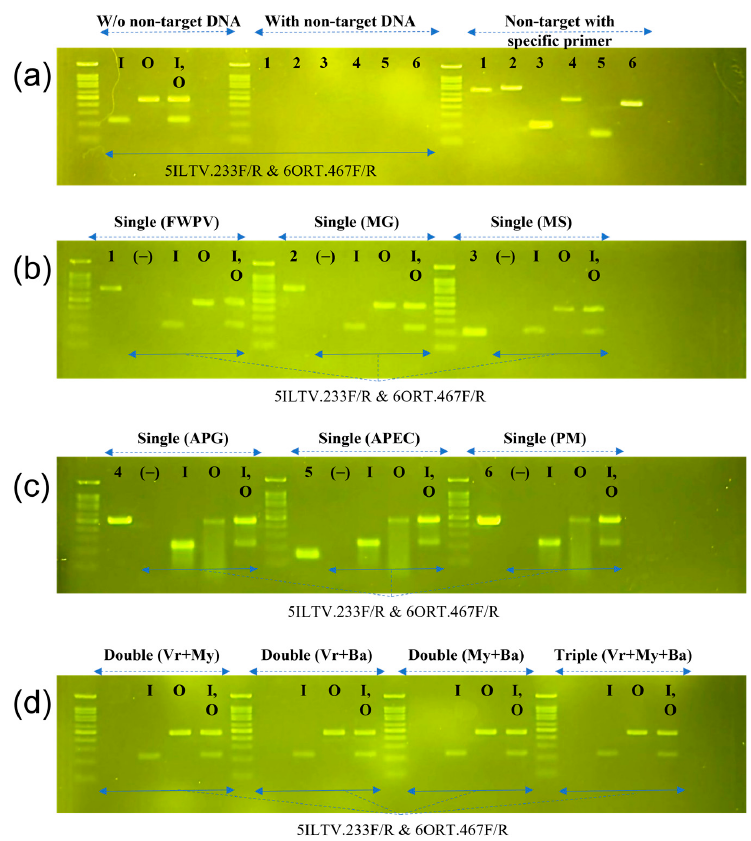
Figure 3. Agarose gel electrophoresis showing the specificity of multiplex PCR. ( a ) Multiplex PCR was performed solely with target DNA of ILTV (I), ORT (O) or both (I, O); and with mixture of non-target DNA of FWPV (1), MG (2), MS (3), APG (4), APEC (5), or PM (6). ( b , c ) The multiplex with target DNA in the presence of single non-target DNA. Distilled water was used as negative control ( − ). ( d ) Six non-target pathogens are divided into three groups of virus (Vr: FWPV), mycoplasma (My: MG, MS), and bacteria (Ba: APG, APEC, and PM). The reactions with target DNA were then performed in the presence double DNA from either Vr + My, Vr + Ba, or My + Ba, as well as in the presence of triple DNA from Vr + My + Ba.